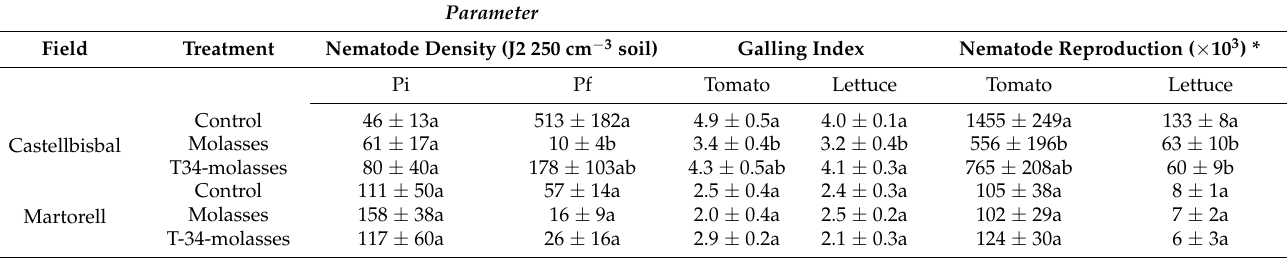
Table 5. Effect of weekly applications of 10 mL m − 2 of molasses alone or combined with Trichoderma asperellum T34 on the nematode densities in soil (Pi; Pf) and in roots (nematode reproduction) and the disease severity (galling index) in the intercropped tomato cv. Bodar at the end of the first nematode generation and the lettuce cv. Paraday at the end of the crop in two organic vegetable production sites.